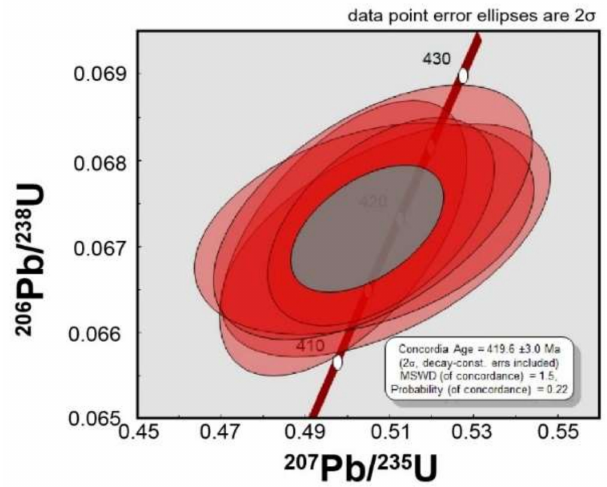
Figure 13. U-Pb concordia diagram for a population of 5 near-concordant zircon analyses (sample LG-80-33-2017), from the Lake George granodiorite plotted on concordia (bold analyses in Table 1). Data point error ellipses are reported at 2 σ .